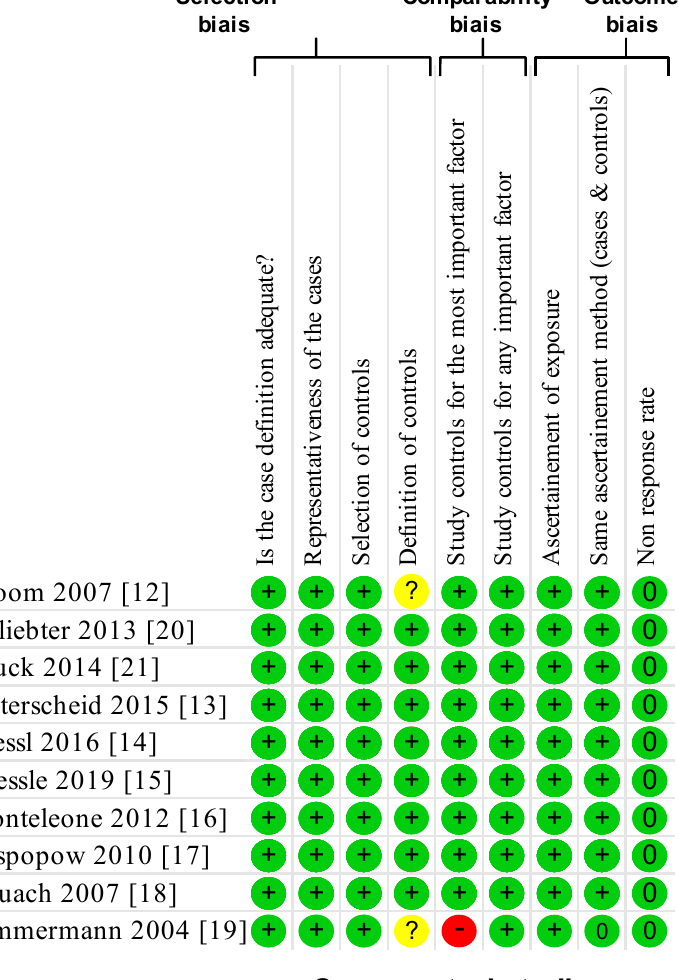
Figure 2. Methodological quality of included articles using the Newcastle–Ottawa Quality Assess- ment Scale. Yes: +; no: -; cannot say: ?; not applicable: NA.